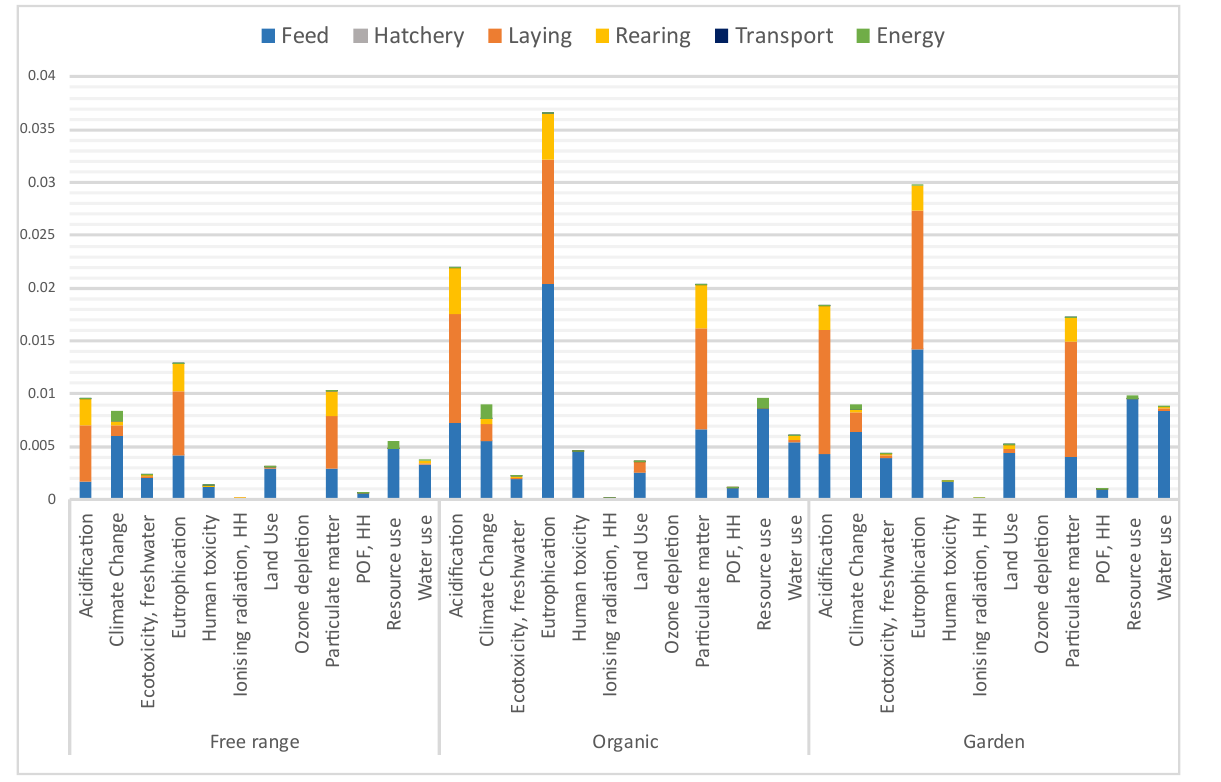
Figure 5. Normalized and weighted results for eggs produced in a community garden compared with free-range and organic eggs, using Environmental Footprint 3.0 for one kilogram of eggs per impact categories.